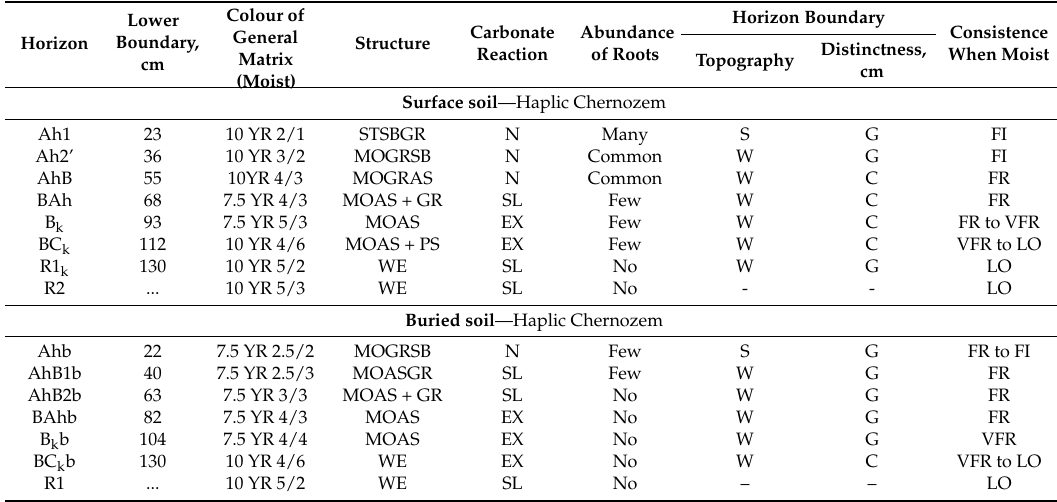
Table 1. Field description of soils, combined with mound of Bronze Age *. Horizon